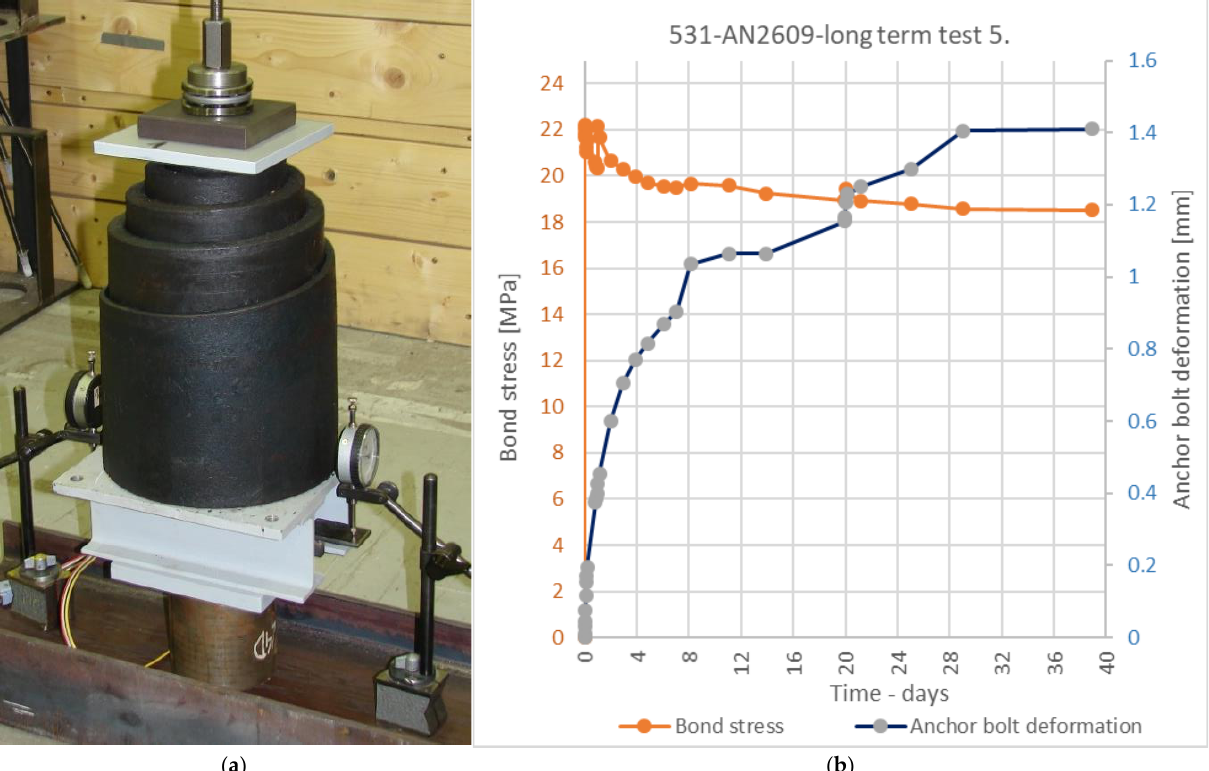
Figure 18. (a) Long-term test CHS Epoxy 531 with AN2609 curing accelerator; ( b ) One long-term test result.